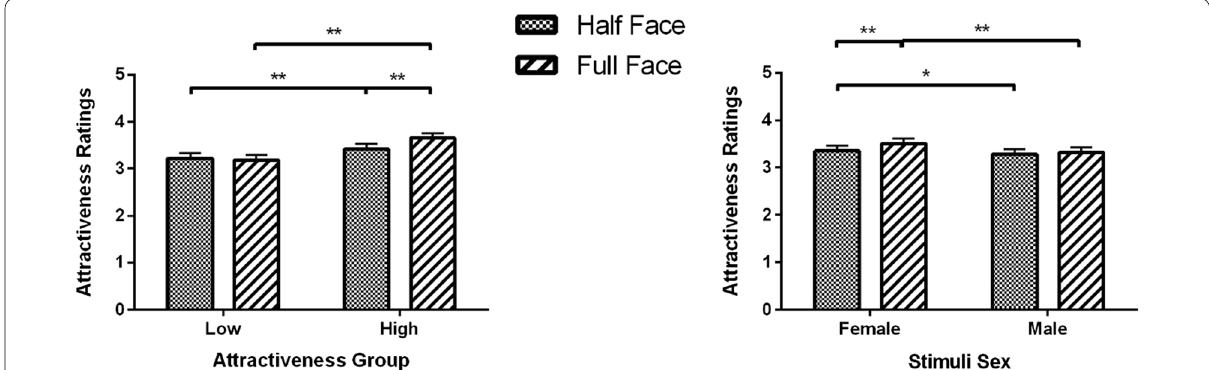
Fig. 7 Attractiveness ratings (Means and SEM) for upper half and full faces as a function of attractiveness group and stimuli sex. * p < 0.05, ** p <